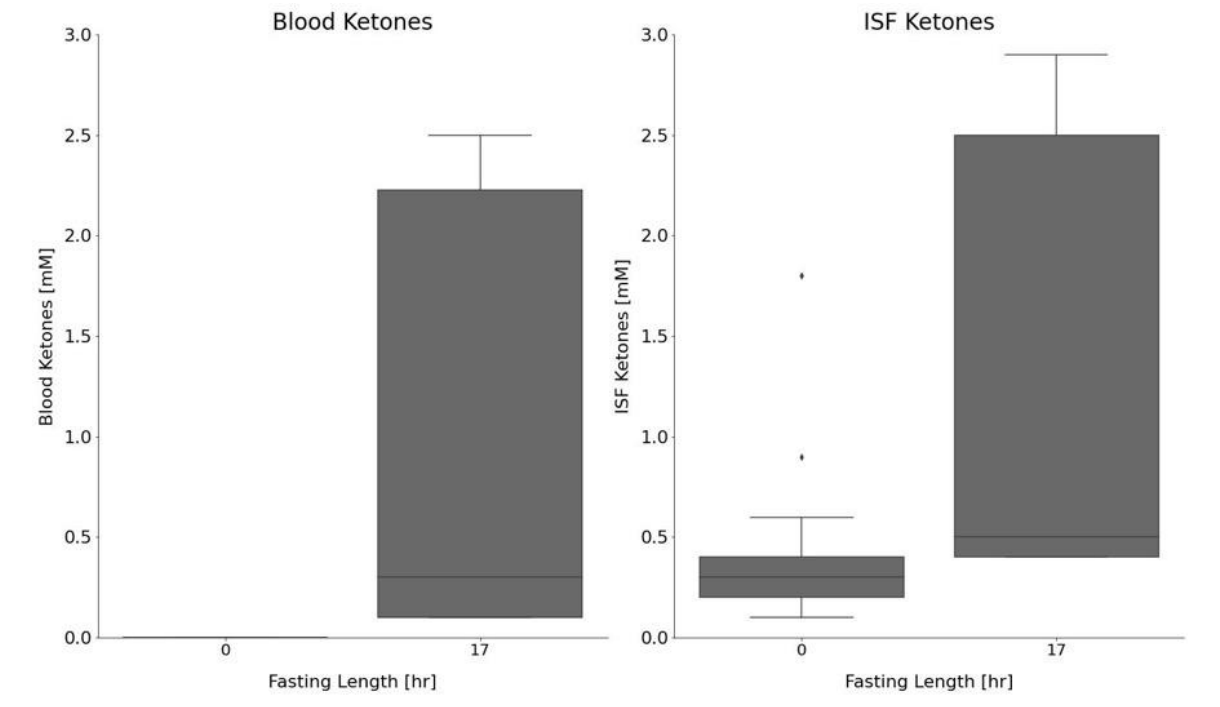
Figure 4. ISF and blood ketones measured in control (non-fasted) and fasted (17 h) CD hairless rats (fasted: n = 2; control: n = 3). Boxplots showing the median (solid line), minimum (bottom whisker), lower quartile (bottom of box), upper quartile (top of box), maximum (upper whisker), outliers (dots), and interquartile range (gray).